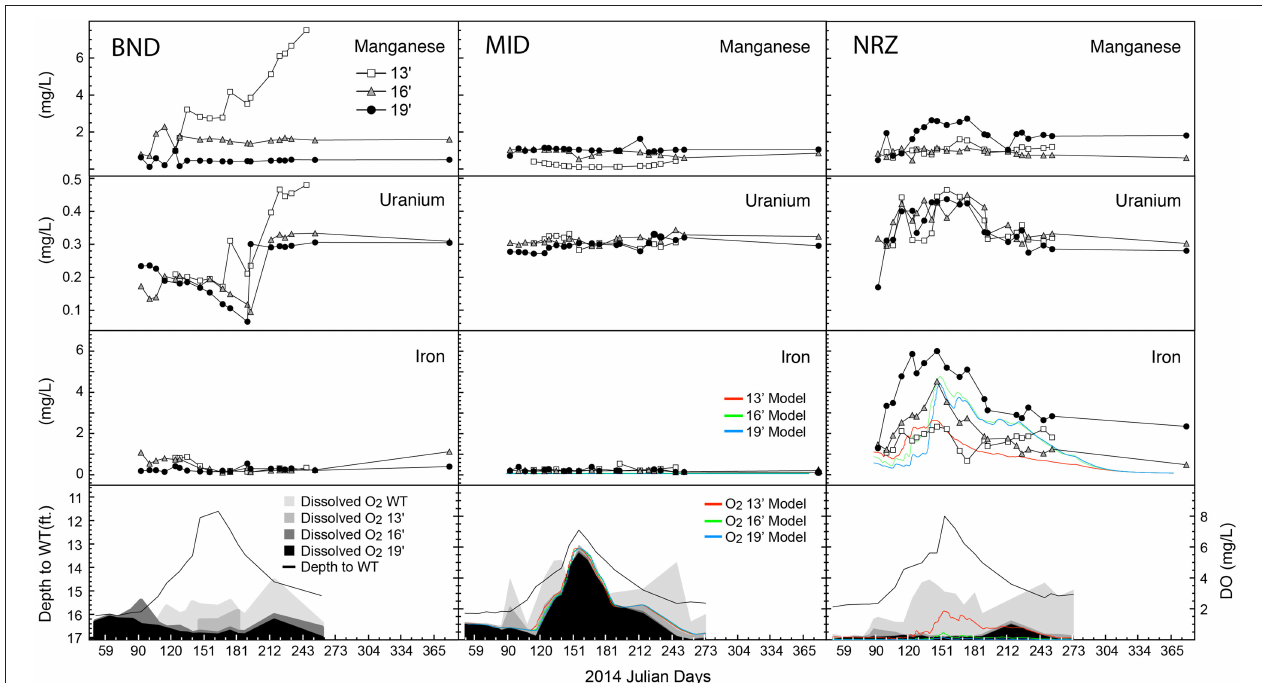
FIGURE 2 | Geochemical parameters and model output plotted over time for each of the well-depth combinations. Depth to water table is plotted alongside dissolved oxygen (DO) content. WT, water table. All metal measurements are provided as total dissolved